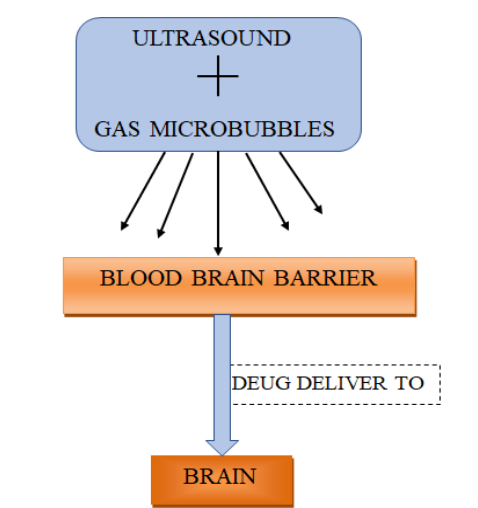
Fig. 13. Schematic representation of focused ultrasound (FUS)